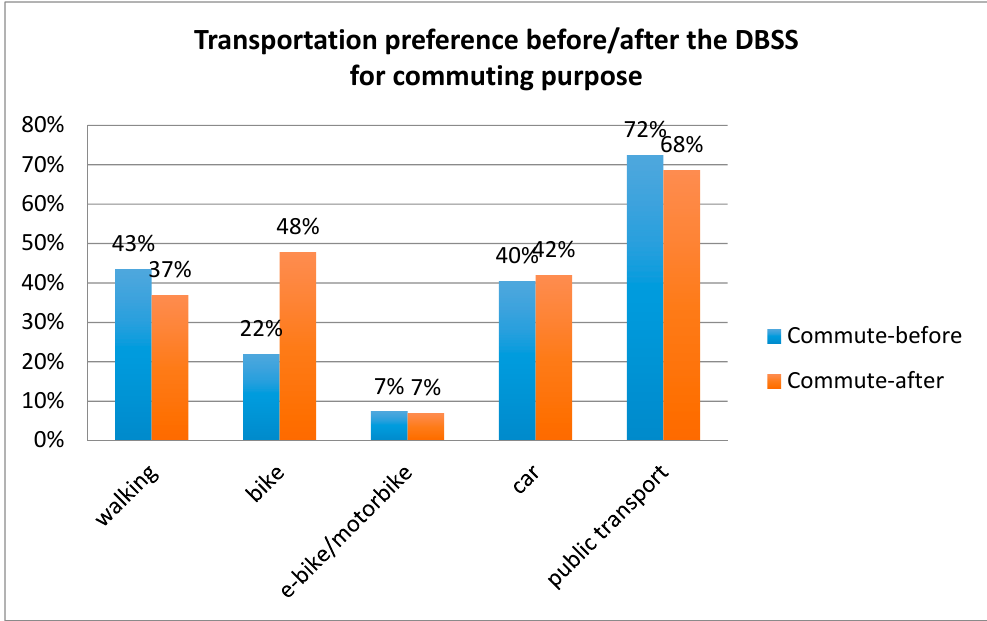
Figure 2. Transportation preference before/after the DBSS for commuting purposes.